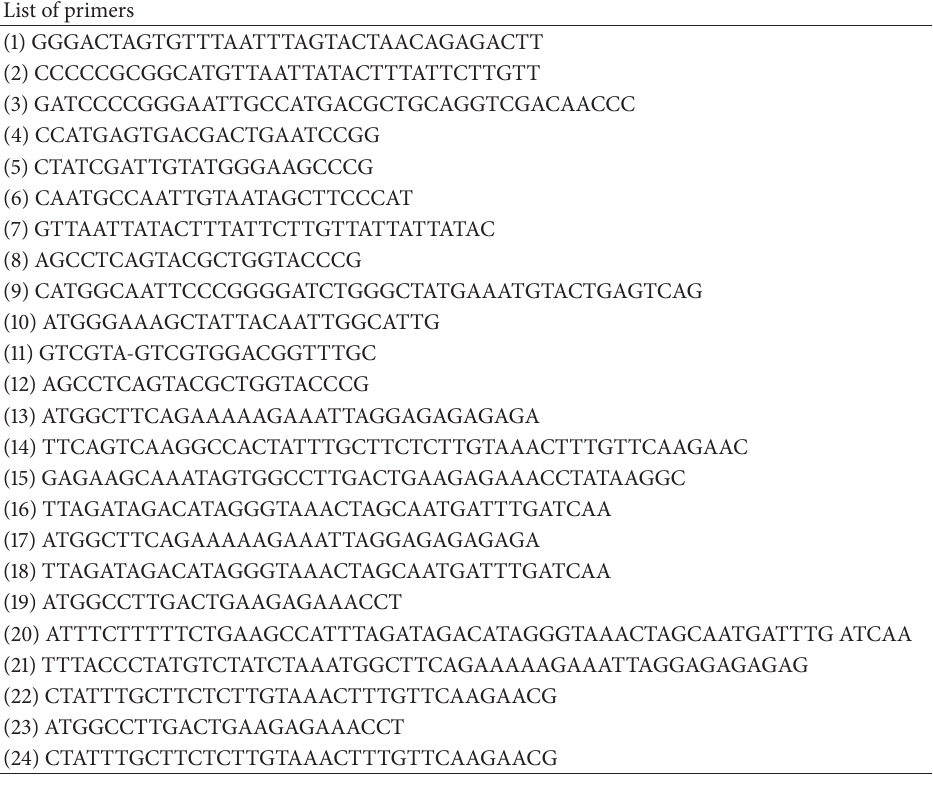
Table 1: List of the primers used in this